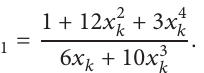
also includes divergence points. The divergence points are included in the black areas and, accordingly, should be out- side of